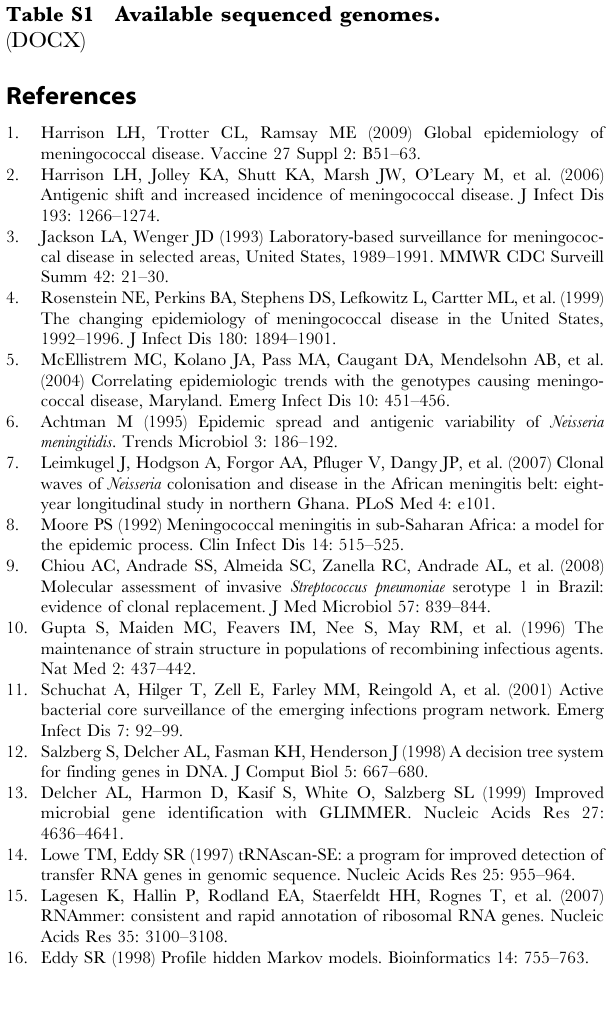
Table S2 Lipoproteins exhibiting identical nucleotide and amino acid sequence in early and late clones and their amino acid identity across sequenced genomes. Table S3 Early clone (NM220) and late clone (NM233) differences in predicted outer membrane proteins, lipoproteins, proteins involved in pilus biogenesis and non-lipoproteins involved in iron acquisition and up- take. Table S4 Proteins encoded by genes found in only one of the